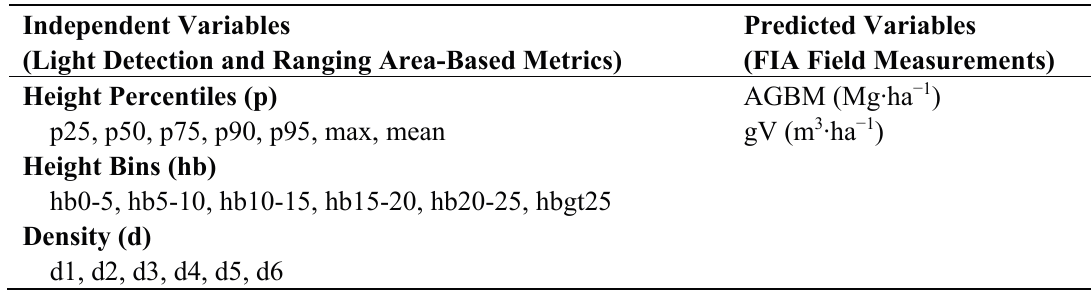
Table 6. Selected regression